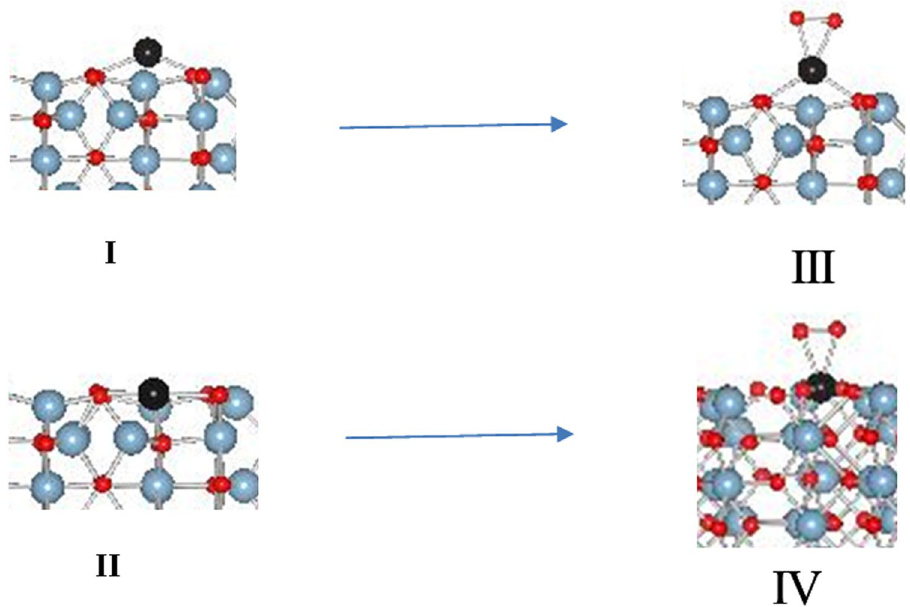
Figure 1. ( I) . Pd adatom and ( II) . Pd cation on θ -alumina (010) surface and corresponding oxidized species, ( III) and ( IV)